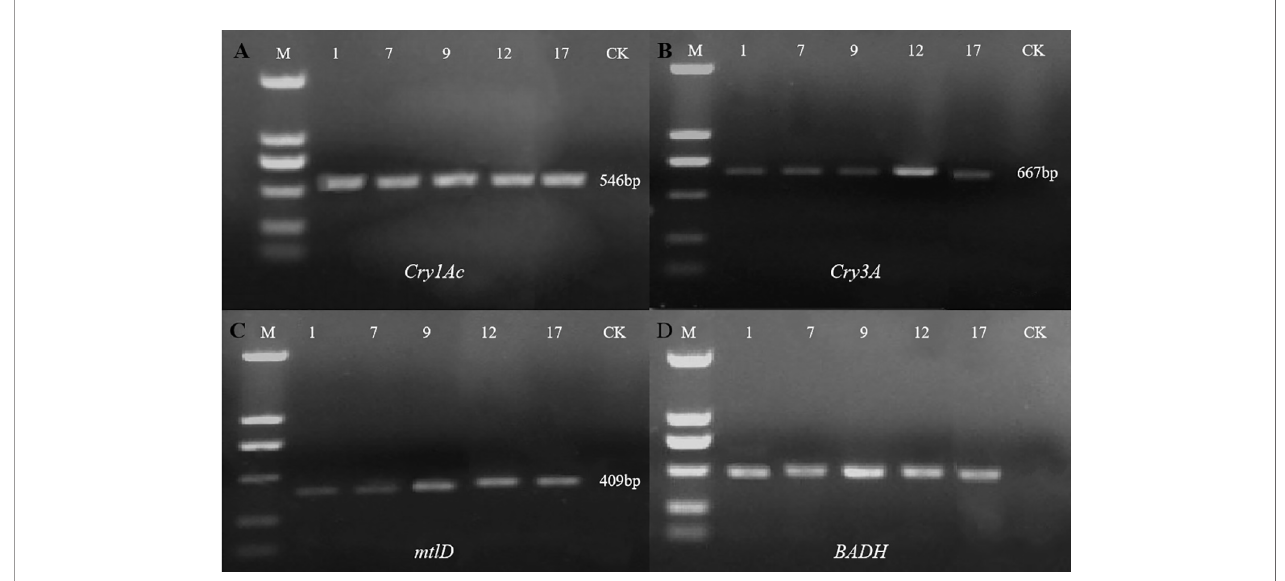
FIGURE 4 | Detection of exogenous genes in fi ve selected transgenic lines. With non-transgenic line (CK) as the control, the exogenous genes in 5 transgenic lines (1, 7, 9, 12, 17) were detected by PCR. M, DL2000 DNA marker (From top to bottom: 2000, 1000, 750, 500, 250, and 100 bp). (A) PCR ampli fi cation of the Cry1Ac gene; (B) PCR ampli fi cation of the Cry3A gene; (C) PCR ampli fi cation of the mtlD gene; (D) PCR ampli fi cation of the BADH gene.